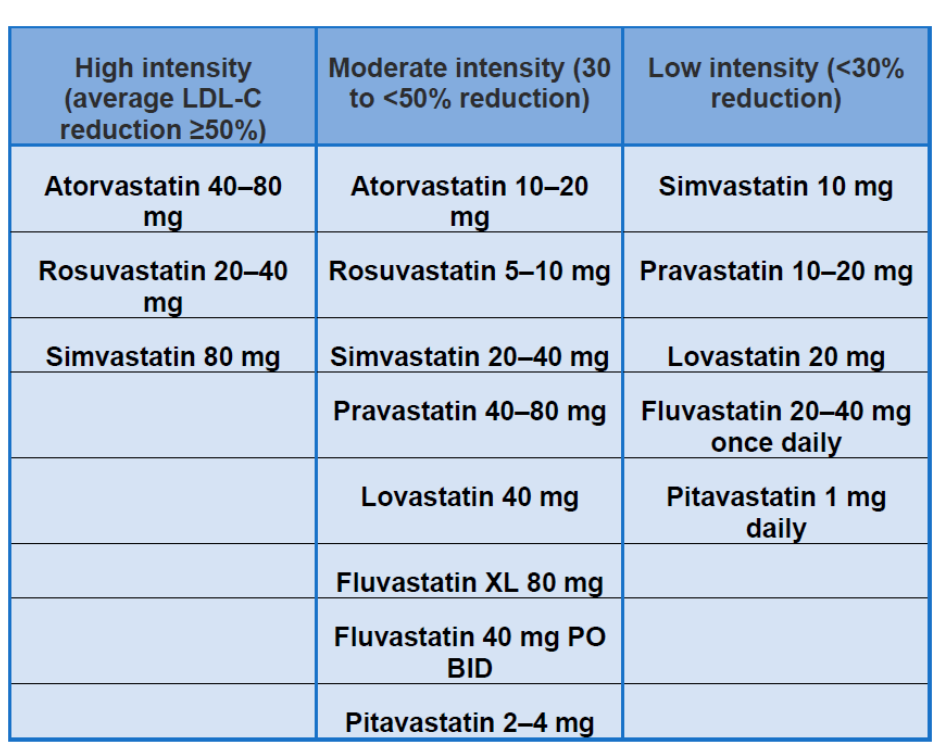
Figure 3. Intensity of statin therapy [12].